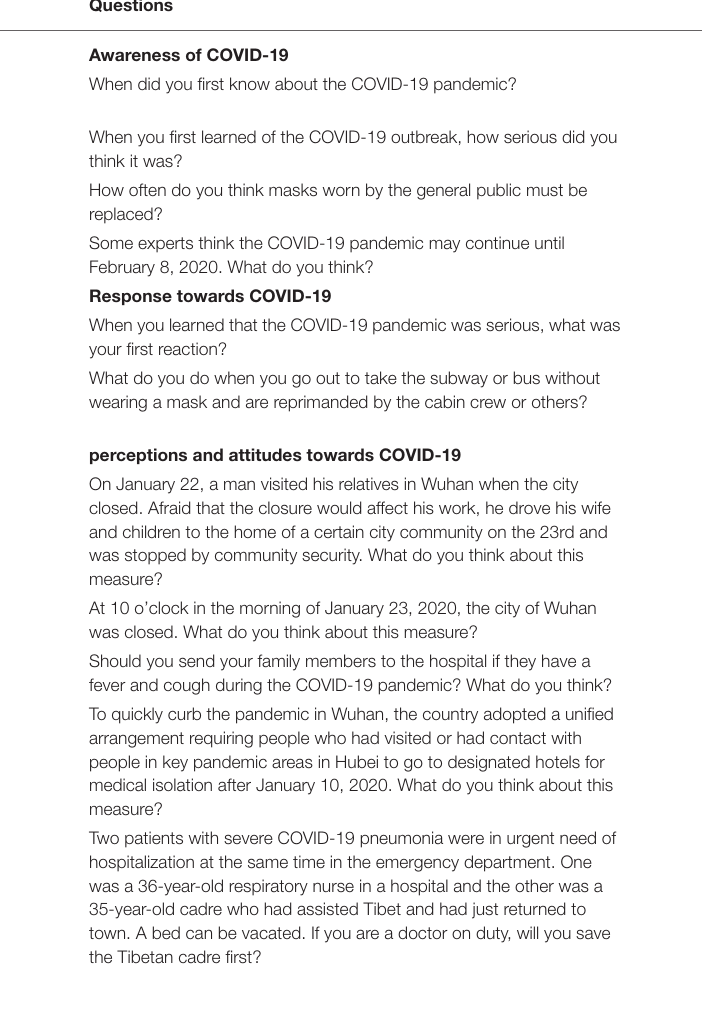
TABLE 1 | Questions and answer options regarding perceptions and attitudes towards COVID-19.